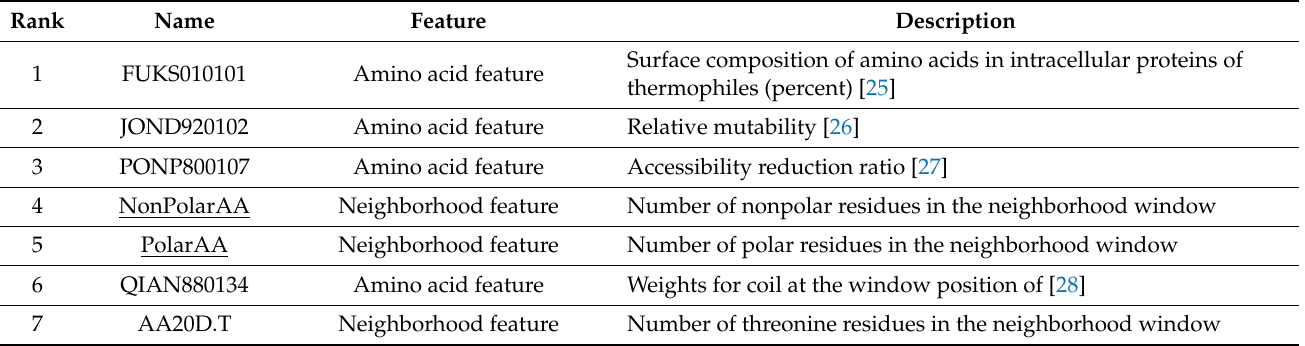
Table 2. Features selected by RFE for two-layer three-class LightGBM decreasing/not decreasing classifier sorted by importance. Features shared by to the two predictors are